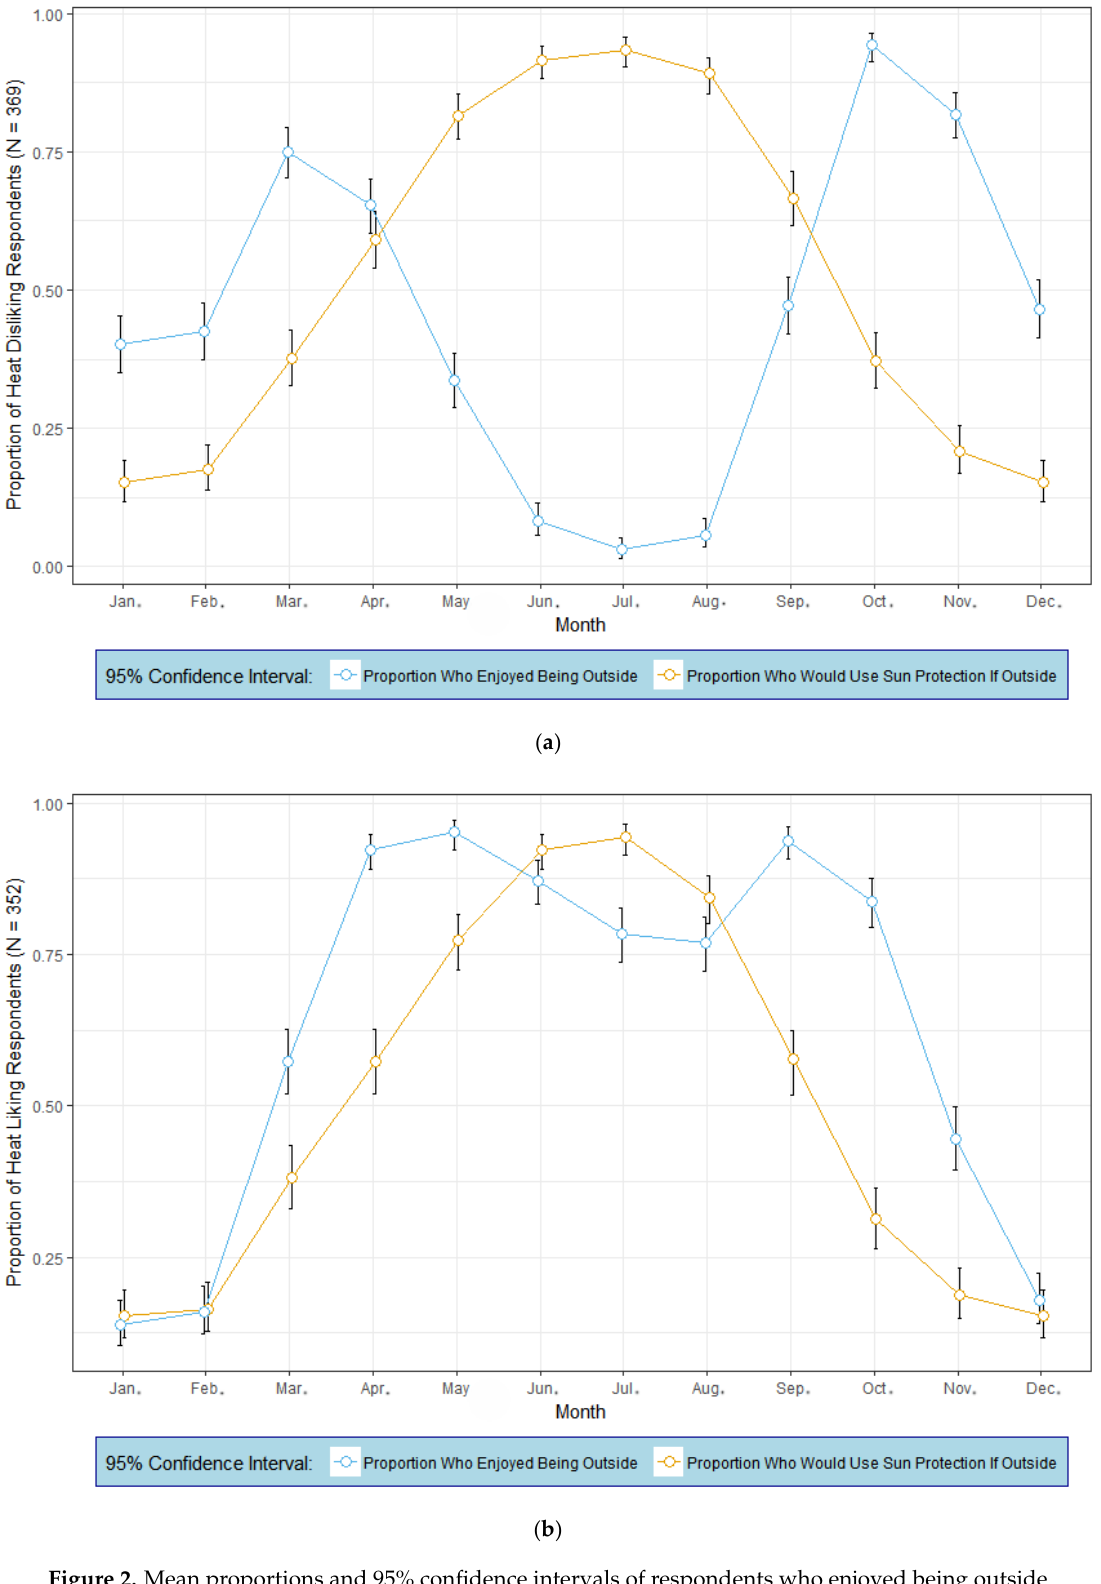
Figure 2. Mean proportions and 95% confidence intervals of respondents who enjoyed being outside (blue profile) and the mean proportion of respondents who would use sun protection if outside (orange profile, by month). ( a ) Heat disliking respondents ( N = 369). ( b ) Heat liking respondents ( N = 352). Note: Sun protection includes behaviors such as seeking shade, wearing sunscreen, wearing protecting clothing, sunglasses, and/or a hat.